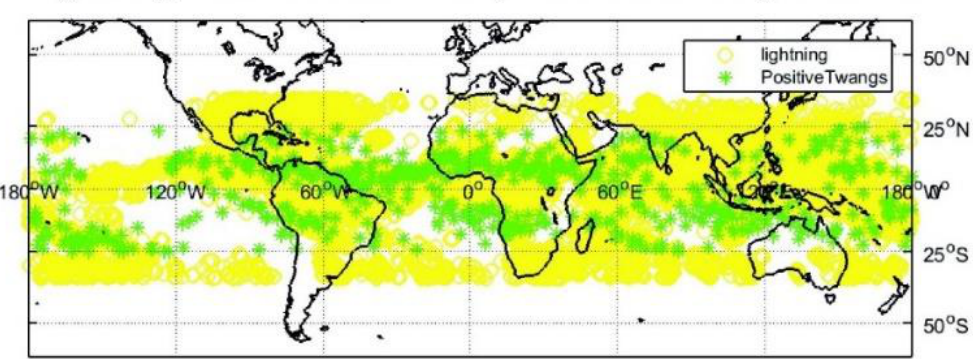
Figure 15. Geographical plot of positive twangs between 25 ◦ north and south in May 2008 together with lightning strikes detected by the World Wide Lightning Location Network (WWLLN), which occurred within a distance of 30 ◦ and a timespan of 30 min around the location and detection time of